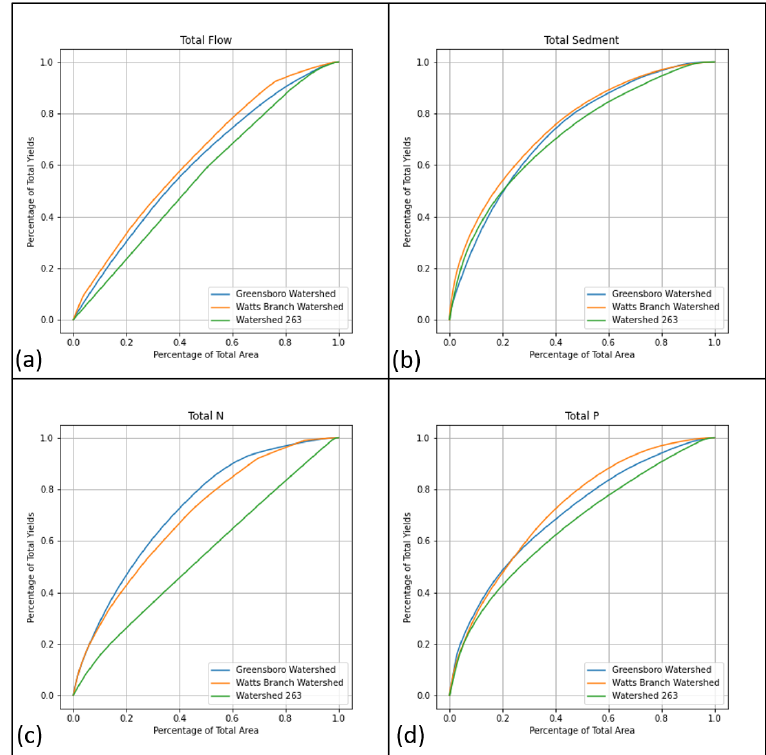
Figure 6. Mass-area ratios of ( a ) total surface flow (SurfQ), ( b ) total sediment (Sed), ( c ) total nitrogen (Total N), and ( d ) total phosphorus (Total P) among three real watersheds.